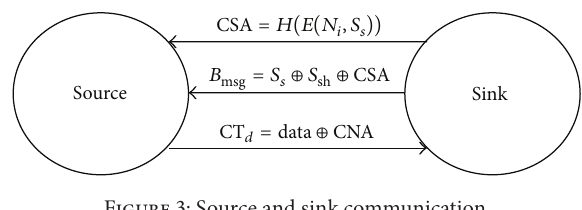
Figure 3: Source and sink